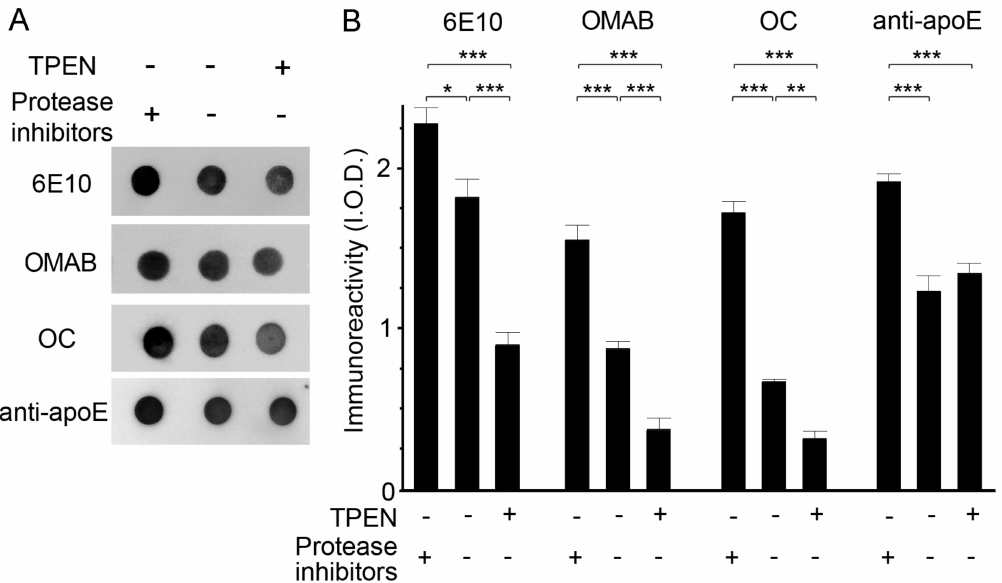
Figure 5. The e ff ects of zinc chelation on endogenous protease-induced apoE / A β degradation. ( A ) Representative dot blots of A β and apoE in whole brain lysates treated with ( + ) or without (-) 100 µ M TPEN in the presence ( + ) or absence (-) of EDTA-free protease inhibitors. ( B ) Quantitative analyses of the levels of apoE and total (6E10), oligomeric (OMAB), or fibril (OC) A β shown in ( A ). The integrated optical densities (I.O.D.) were arbitrarily measured for the immunoreactivities. Data are from three independent experiments using brain lysates from the same Tg2576 mouse. * p < 0.05, ** p < 0.01, and *** p < 0.001 by one-way ANOVA.